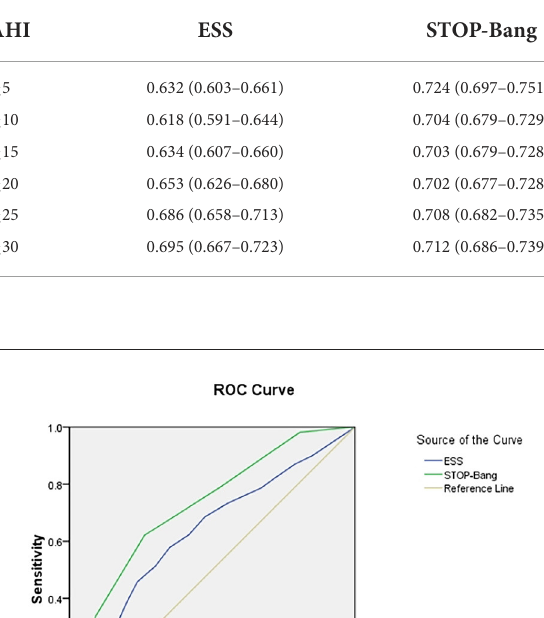
TABLE 2 The area under the receiver operating curve of various scales.